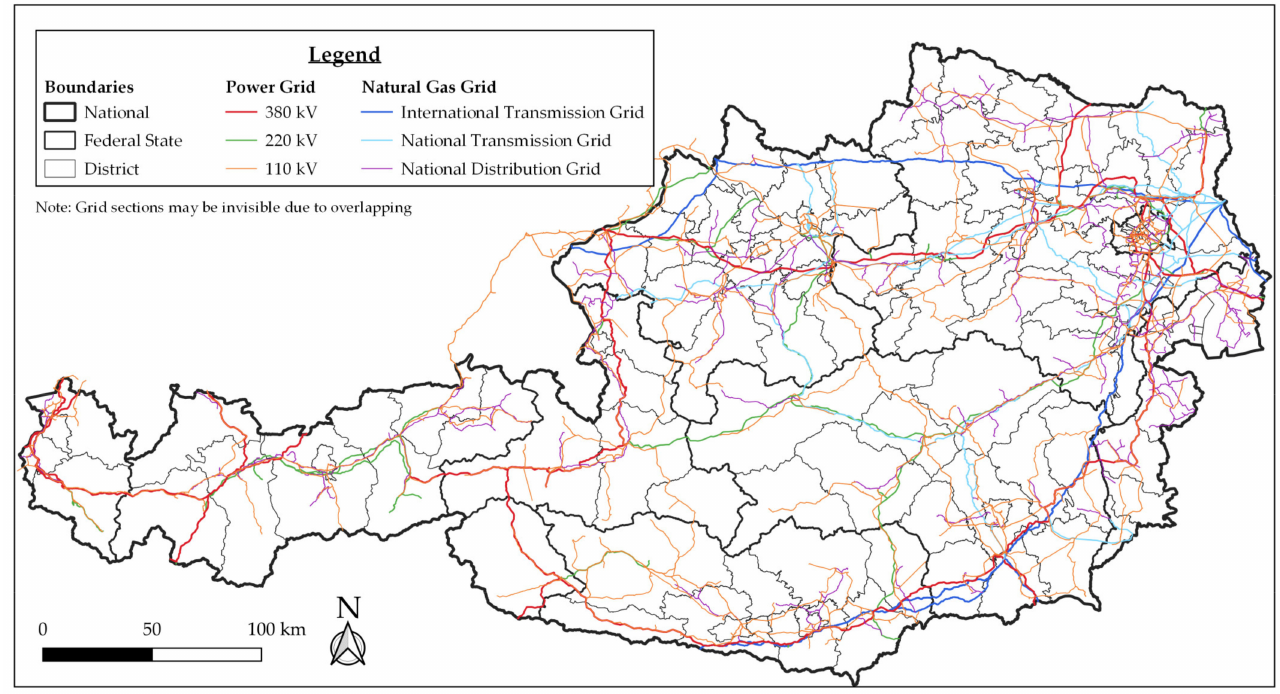
Figure 8. Model of Austria’s power and natural gas infrastructure